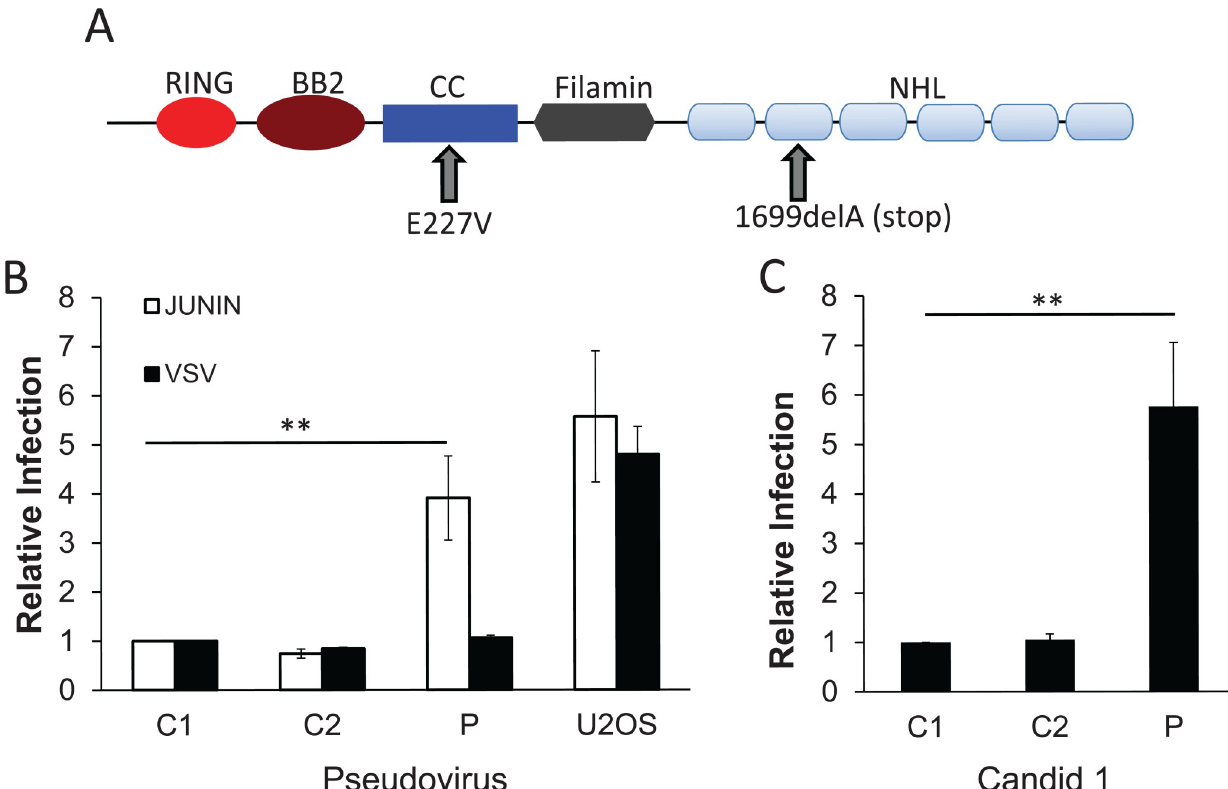
Fig 3. Cells from a Charcot–Marie–Tooth disease patient with TRIM2 mutations are more susceptible to Junı´n virus infection. (A) Diagram of the mutations found in the TRIM2 alleles (see [26] for more details). (B) Primary fibroblasts from patient (P) or 2 different control patients (C1, C2) were infected with Junı´n GP or VSV G MLV pseudoviruses encoding the luciferase protein and analyzed for luciferase activity 48 hpi. (C) The same fibroblasts were infected with Candid 1 and analyzed for viral RNA levels by RT-qPCR at 24 hpi. Shown are the averages ± SD of 3 different experiments with passages 4, 5, and 6 of the cells. P values were determined by unpaired t tests; �� P � 0.005. CC, coiled-coil; hpi, hours post infection; MLV, murine leukemia virus; RT-qPCR, real-time quantitative PCR; VSV, vesicular stomatitis